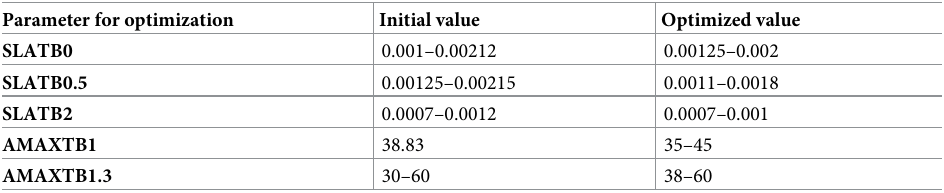
Table 1. Initial values and optimized values of sensitive